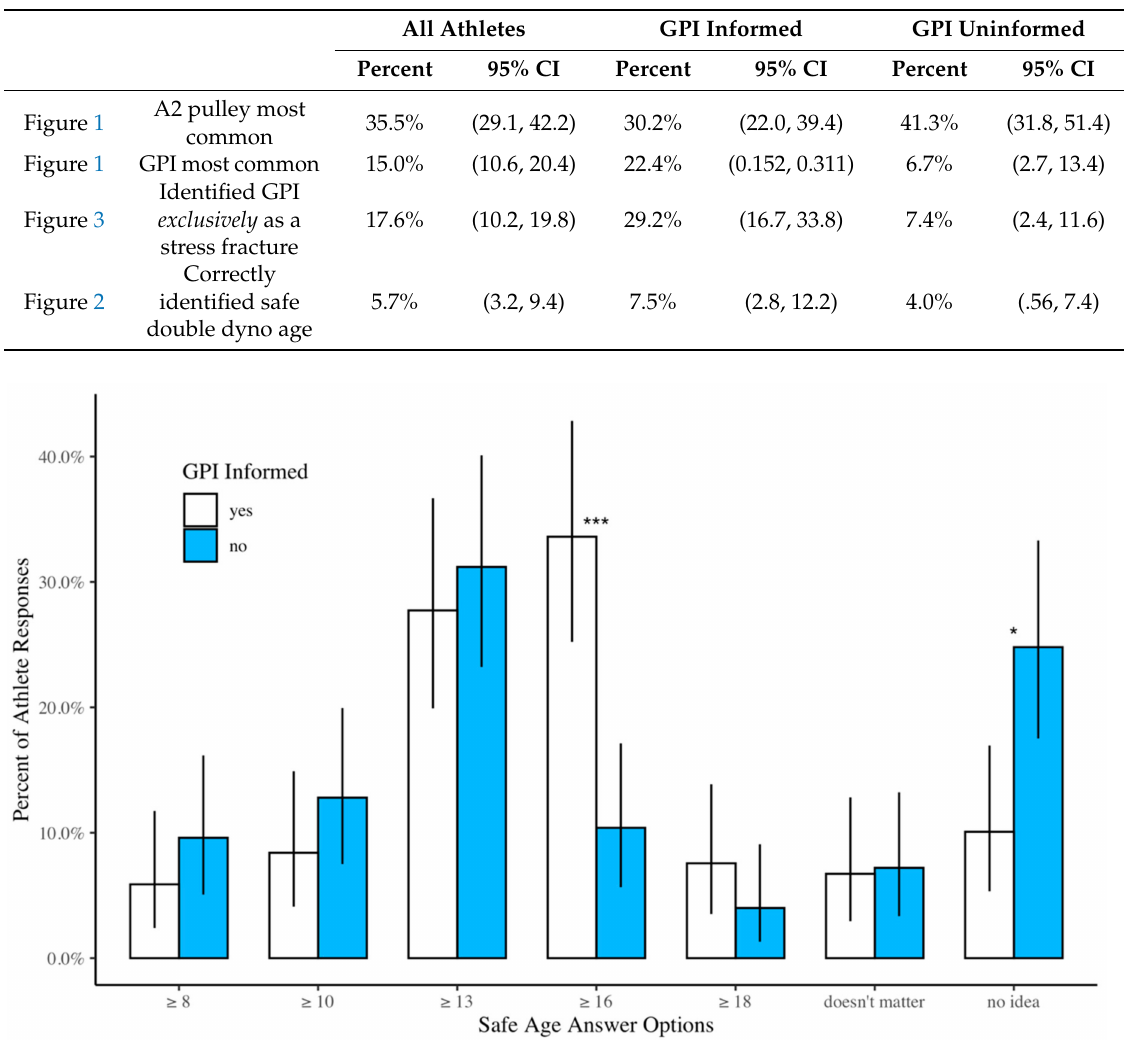
Figure 2. Athlete responses to the question “What is the safe age to start double dyno campus boarding?” Statistically significant comparisons between GPI informed and GPI uninformed are indicated with one asterisk ( p < 0.05) or three asterisks ( p <